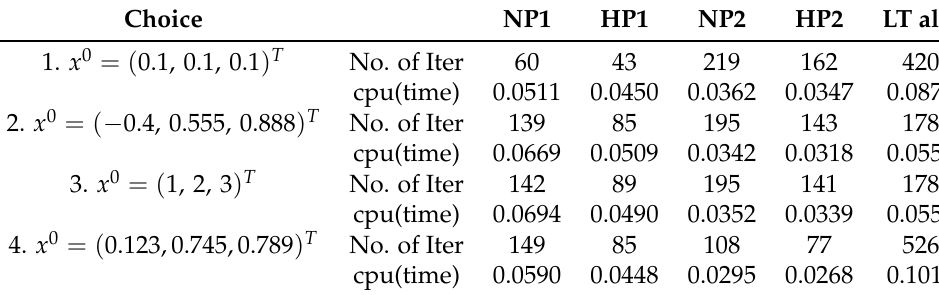
Table 2. Numerical results of five algorithms for Example 1. Choice